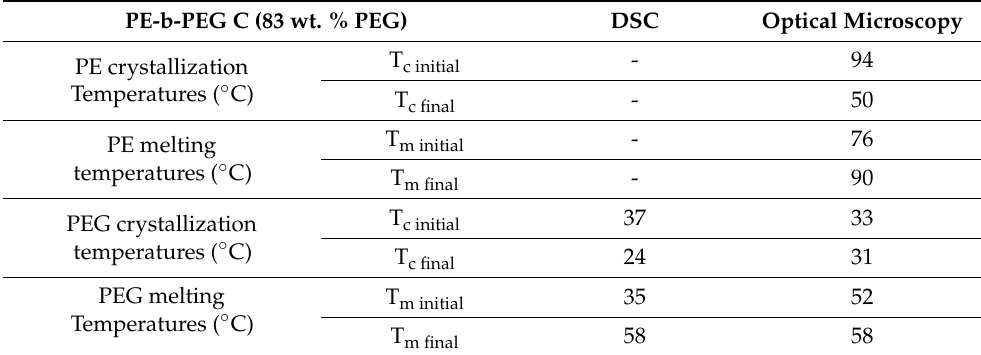
Table 4. Comparison of the melting and the crystallization temperatures of PE and PEG blocks for PE-b-PEG C obtained by optical microscopy and DSC.